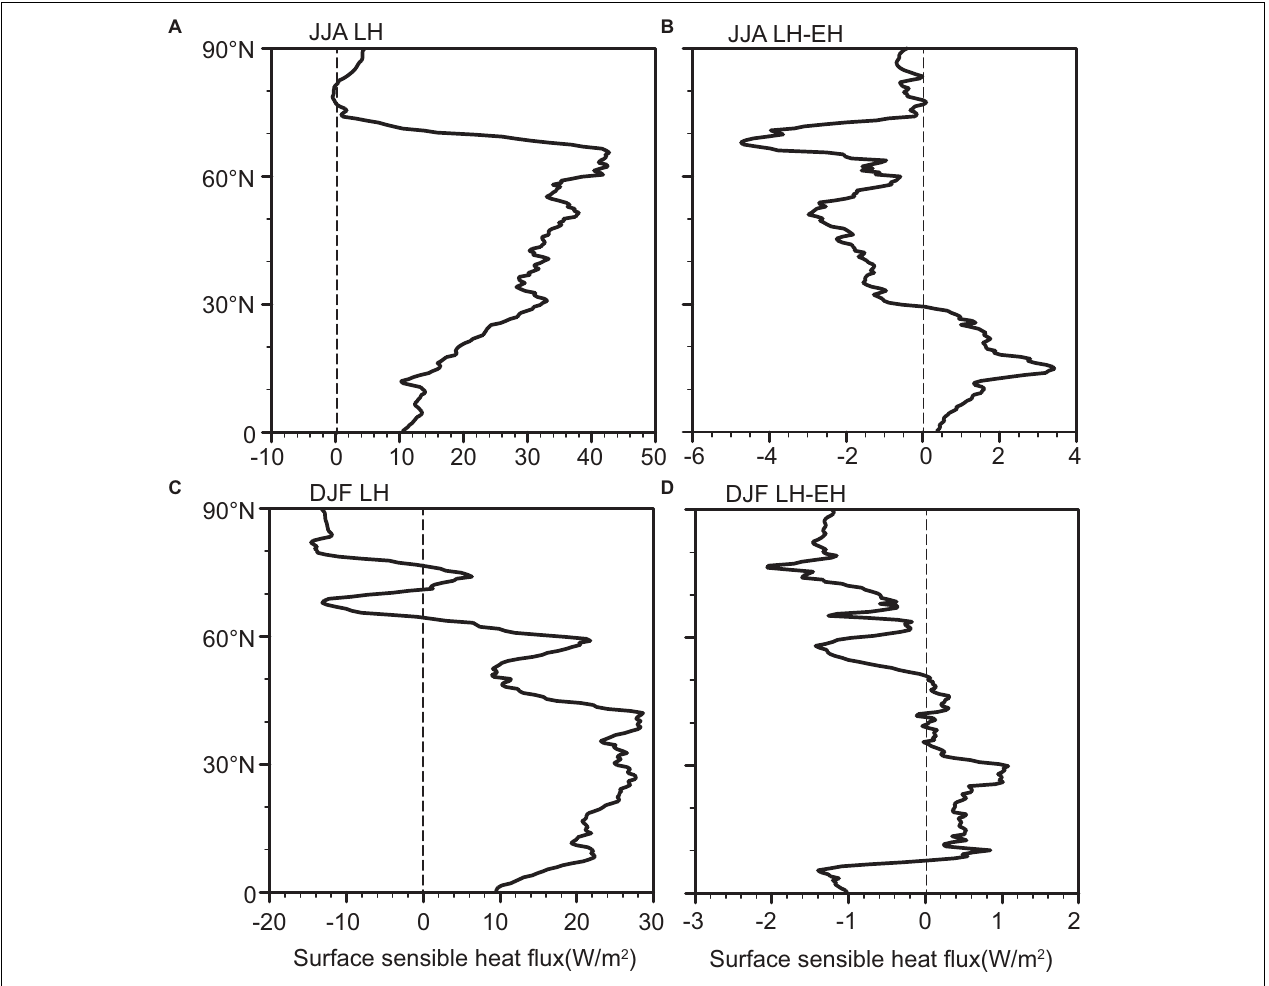
FIGURE 13 | Zonal mean surface sensible heat flux. Summer and winter surface sensible heat flux in LH (A,C) and the LH-minus-EH difference (B,D) .